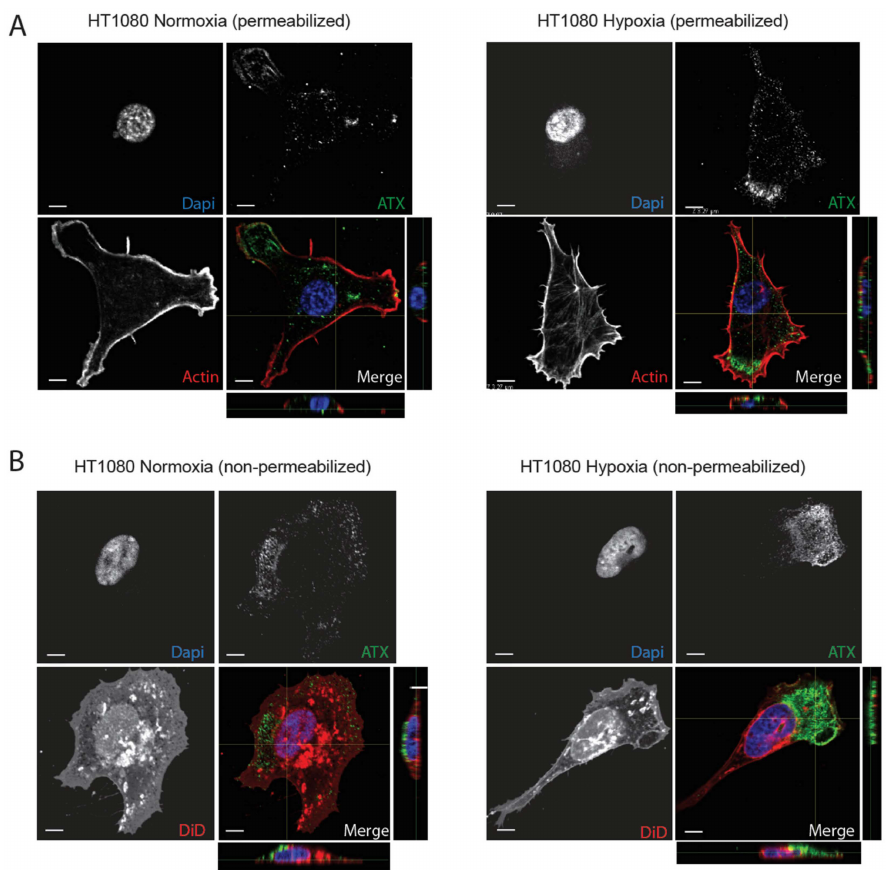
Figure 4. ATX localization in hypoxic cancer cells. ( A – B ) Representative immunofluorescence images of HT1080 cells cultured on non-fluorescent gelatin for 4 h in normoxia (21% O 2 ) or hypoxia (1% O 2 ) are shown. ( A ) Representative images of cells permeabilized and stained for ATX (green) or F-actin (red). Nuclei were stained with DAPI (blue). Magnification 60 × , scale bars, 5 µ m. ( B ) Representative images showing ATX (green) and the lipophilic carbocyanine DiD (red) staining in non-permeabilized cells. Nuclei were stained with DAPI (blue). Magnification 60 × , scale bars, 5 µ